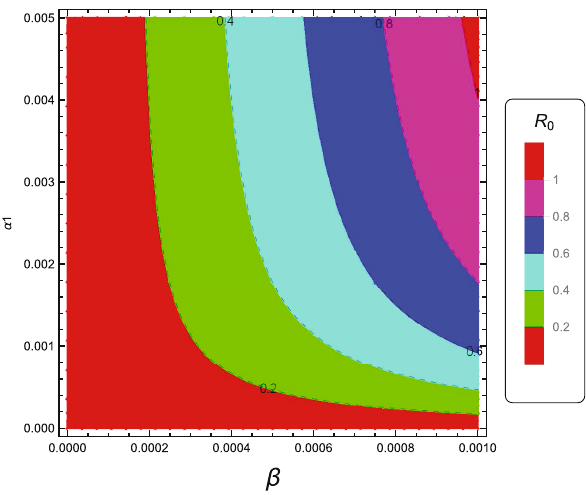
Figure 6: Variation of R 0 with respect to β and α 1 .